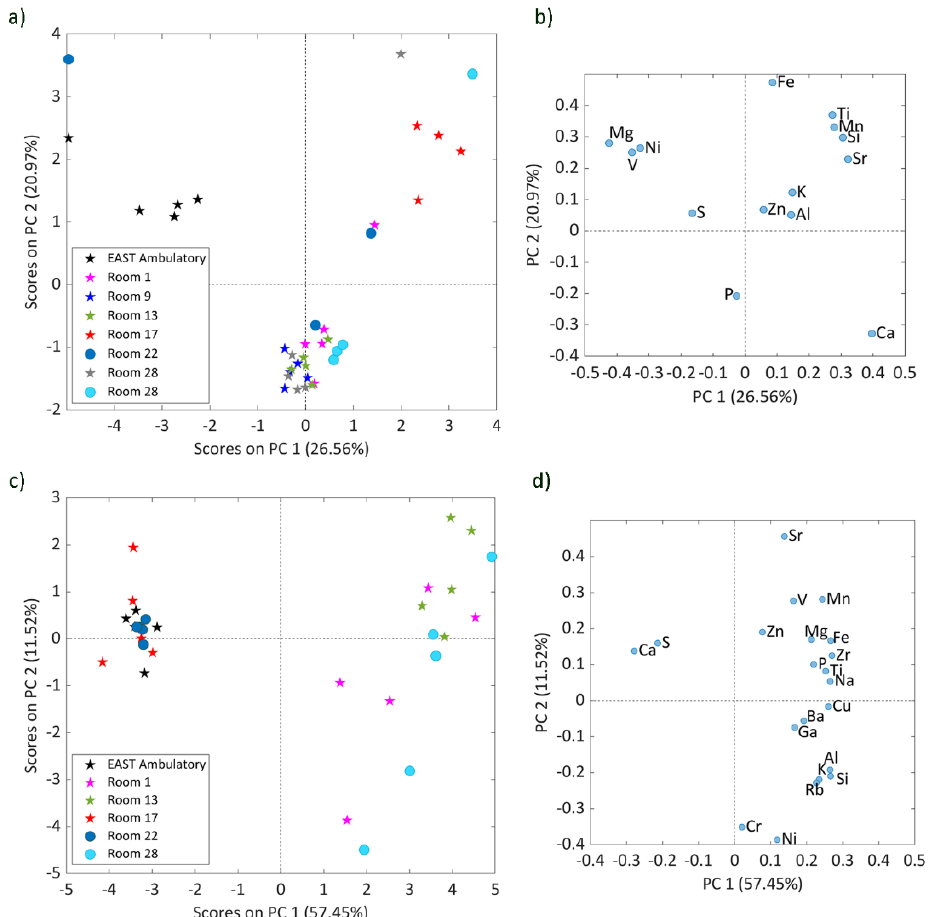
Figure 6. PCA of EDXRF data for white tesserae ( a ) score; and ( b ) loading plots in the space of PC1 vs. PC2 for 47.5% of total variance; and for black tesserae ( c ) score; and ( d ) loading plots in the space of PC1 vs. PC2 for 69.0% of total variance.